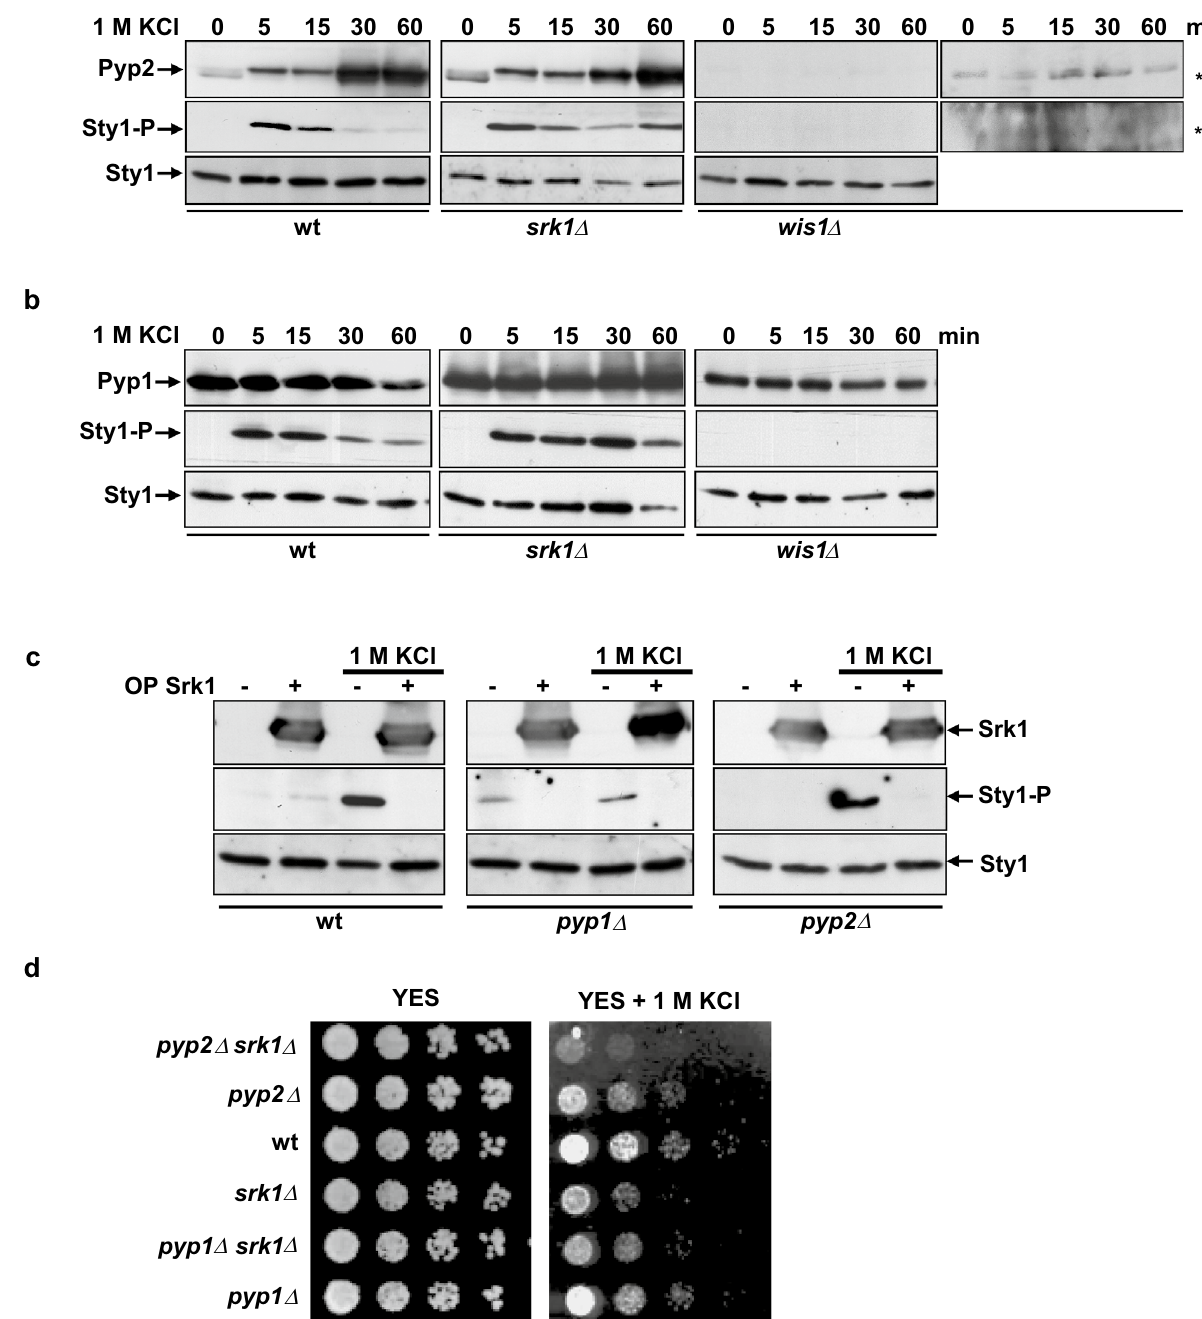
Figure 2. MAP phosphatase levels and activity are not dependent on Srk1. ( a ) and ( b ), S. pombe wild-type, srk1∆, and wis1∆ cells expressing genomic pyp2:HA6his ( a ) and pyp1:HA6his ( b ) were grown in YES medium to mid-log phase and remained untreated (0 min) or treated with 1 M KCl at the indicated times, up to 60 min. Activated (Sty1-P) and total Sty1 were detected with anti-phospho p38 and anti-HOG1 antibodies, respectively. Total Pyp2 ( a ) and Pyp1 ( b ) levels were detected with anti-HA antibody. *longer exposure of Pyp2 and P-Sty1 levels are shown in Δwis1. ( c ) Wild-type, pyp1∆ and pyp2∆ cells with ( +) or without (-) Srk1 overexpression (OP Srk1: through the inducible plasmid pREP1-srk1:HA6his) during 20 h, were untreated (0 min) or treated with 1 M KCl for 15 min. Activated (Sty1-P) and total Sty1 were detected with anti-phospho p38 and anti- HOG1 antibodies, respectively. The level of overexpressed Srk1 was detected with anti-HA antibody. All blot membranes were cut prior antibodies incubation, ( d ) Decimal dilutions of strains of the indicated phenotypes were spotted on YES solid plates with or without 1 M KCl that had been incubated at 30 °C for 3 days and